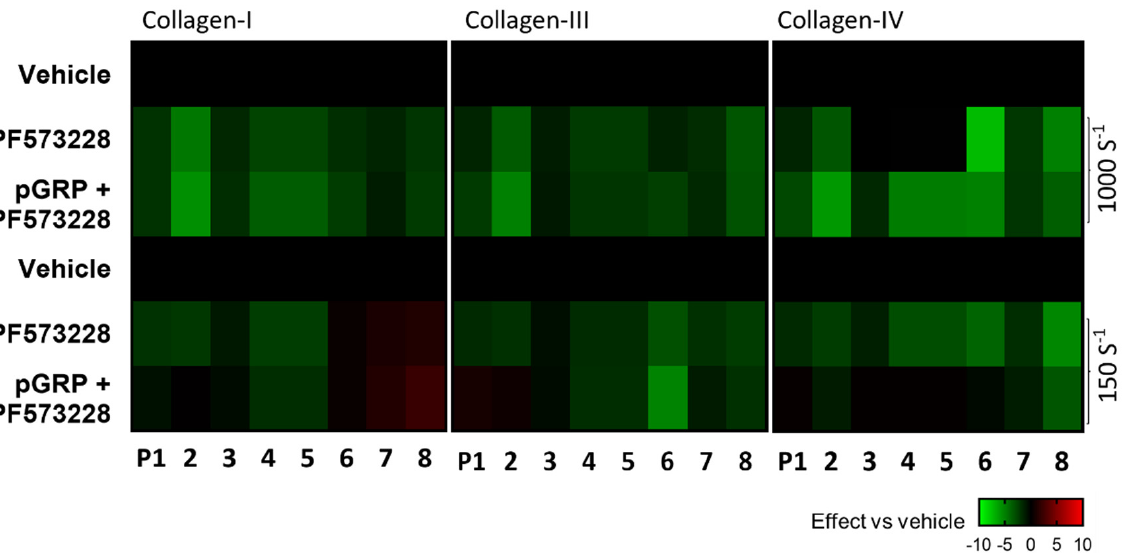
Figure 4. Shear rate dependency of GPR56 and PTK2 interference. Blood samples pre-incubated with vehicle (control) or PF573228 (5 µ M) with/ without pGRP (50 µ g/mL) for 10 min and then perfused over collagen microspots for 3.5 or 6 min at a wall-shear rate of 1000 s − 1 or 150 s − 1 . Parameter analysis of recorded images was as for Figure 1. Shown is a subtraction heatmap representing control-subtracted scaled (0–10) parameter values for collagen I, III, and IV microspots. The color code represents a decrease (green) or increase (red) in comparison to vehicle control runs.